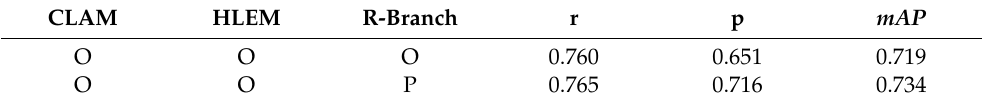
Table 14. Effectiveness of R-branch when the other two modules are not